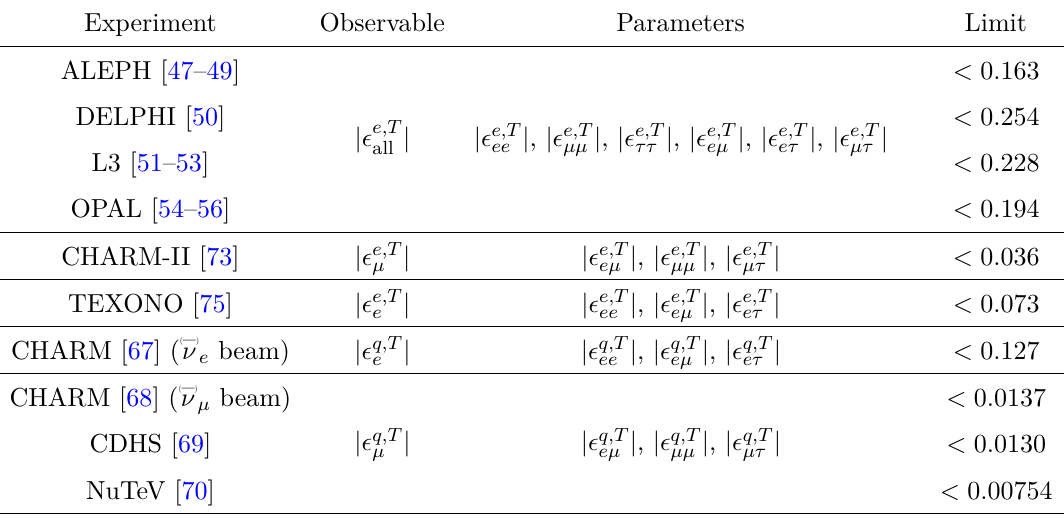
Table 5 . Exclusion 90% C.L. limits on the observable tensor neutrino interaction parameter for different